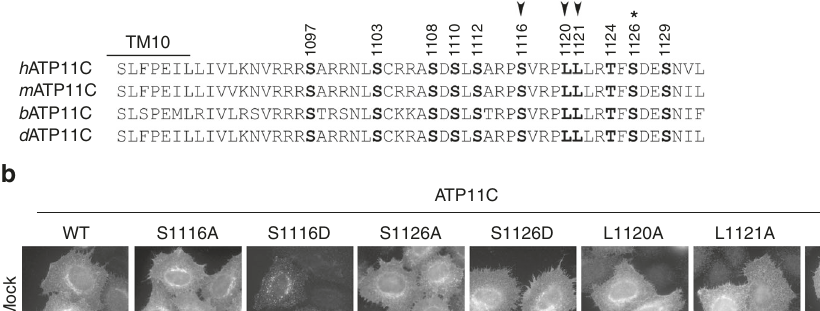
targeting signal of Lyn 55 and EGFP, Fig. 7a), which is fused to the C-terminal cytoplasmic region of ATP11C: CT-WT, CT-9-Ala (9 Ser/Thr to Ala), CT-8-Ala-S1116 (8 Ser/Thr to Ala, except Ser1116), and CT-8-Ala-S1126 (8 Ser/Thr to Ala, except Ser1126) (Fig. 7b). All constructs localized to the plasma membrane in the absence of PMA (Fig. 7Cc, Mock). Lyn-EGFP-CT-WT, but not the original construct Lyn-EGFP-FRB ( − ), was internalized upon treatment of cells with PMA, indicating that the C-terminal region of ATP11C is suf fi cient for PMA-induced endocytosis (Fig. 7c, a middle panel). Lyn-EGFP-CT-WT was also inter- nalized following an increase in cytosolic Ca 2+ by A23187 treatment (Fig. 7c, a bottom panel). Importantly, the Lyn-EGFP- CT-8-Ala-S1116 mutant was internalized as ef fi ciently as Lyn- EGFP-CT-WT upon PMA or A23187 treatment (Fig. 7c). By contrast, the Lyn-EGFP-CT-9-Ala or Lyn-EGFP-CT-8-Ala-S1126 mutant was not internalized upon treatment of cells with either PMA or A23187 (Fig. 7c), although the di-leucine residues (Leu1120/1121) were present in these constructs (Fig. 7b). These results demonstrate that the Ser1116 phosphorylation in the C- terminal region of ATP11C by PKC creates a functional di- leucine motif that is suf fi cient for endocytosis.